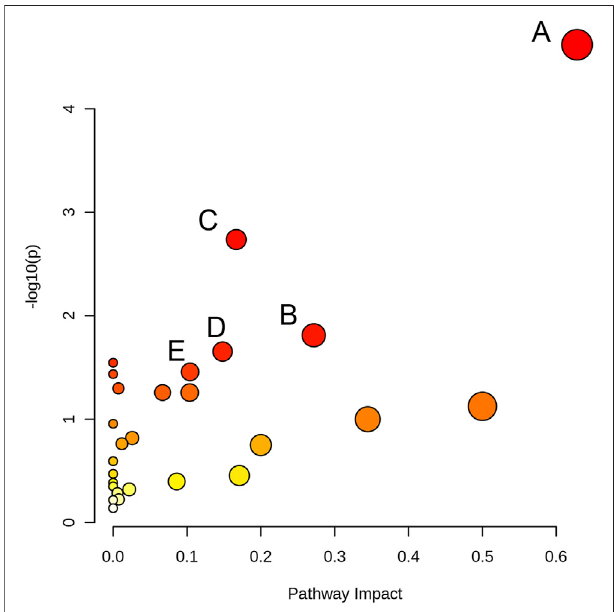
FIGURE 6 | Pathway analysis overview depicting altered metabolic pathways in A549 cells from control and 80 μ M EGCG-treated groups. The metabolic pathways are displayed as distinctly colored circles depending on theirenrichmentanalysisscores(verticalaxis,shadeofred)andtopology (pathway impact, horizontal axis, circle diameter) via MetaboAnalyst 5.0. (A) : Glycine, serine and threonine metabolism, (B) : Alanine, aspartate and glutamate metabolism, (C) : Aminoacyl-tRNA biosynthesis, (D) : Glyoxylate and dicarboxylate metabolism E: Arginine and proline